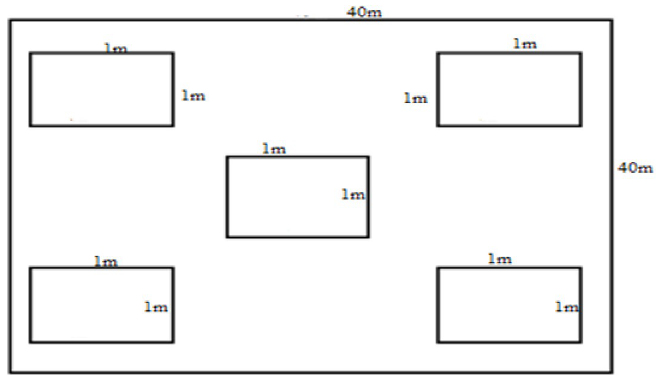
Fig 2. A graphic representation of direct observation of crop loss assessment